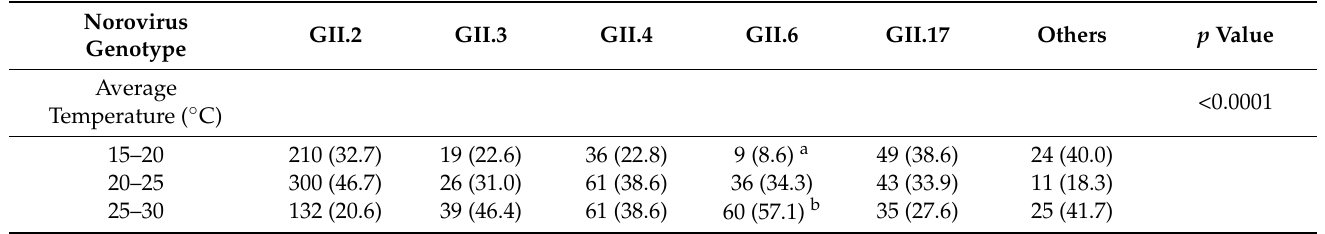
Table 3. Relationship between norovirus genogroup II genotypes and temperature in